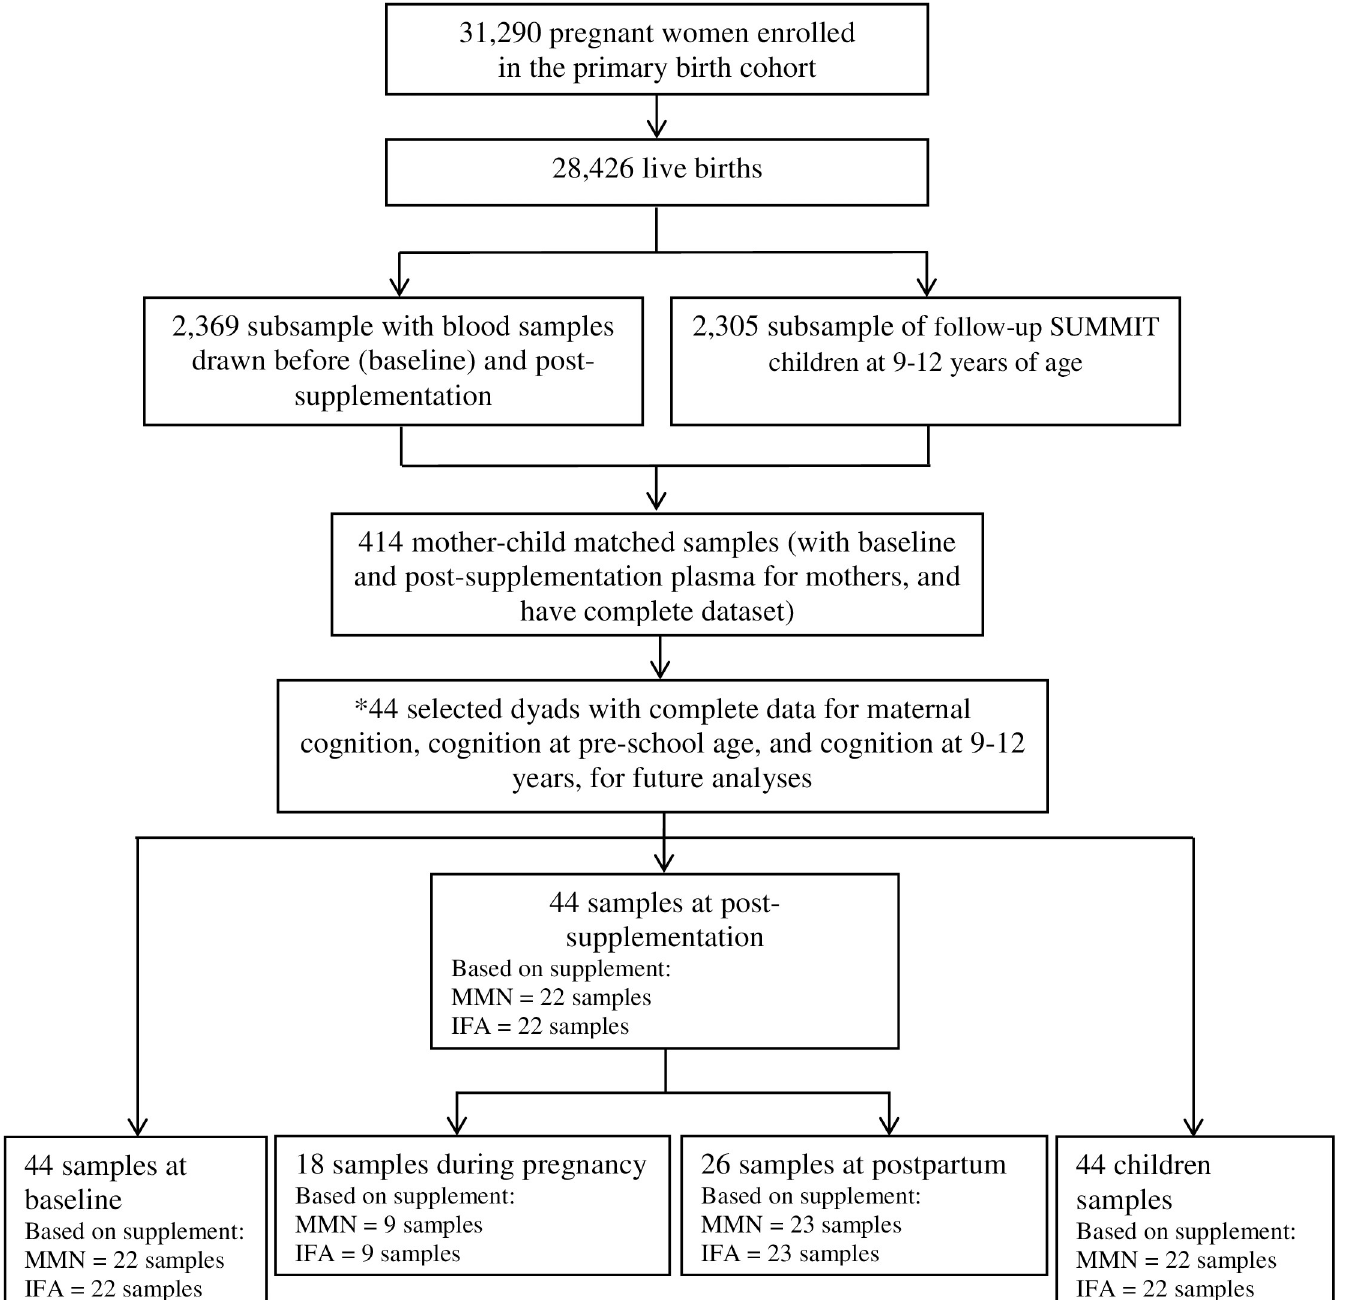
Fig 2. Participant and specimen selectionflow chart. IFA = iron folic acid; MMN = multiple micronutrients. � 44 paired maternal-child plasma specimens were selected, consisting of 22 each of the MMN and the IFA groups, with data for maternal cognition, cognition at pre-school age, and cognition at 9–12 years [40]. https://doi.org/10.1371/journal.pone.0216848.g002 The principal component (PC) scores for retained components were computed for each specimen type (baseline, post-supplementation, and child), then normalized to a mean of 0 and standard deviation of 1 and used as either the independent or dependent variable in regres- sion models. To include post-supplementation PC scores in regression analyses, we merged the